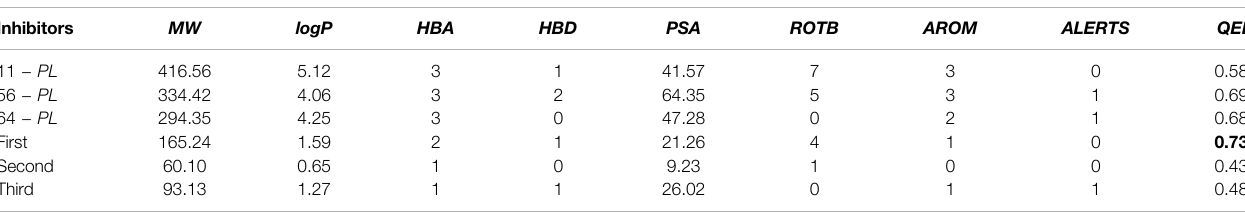
TABLE 3 | Some properties of new inhibitors and original inhibitors.